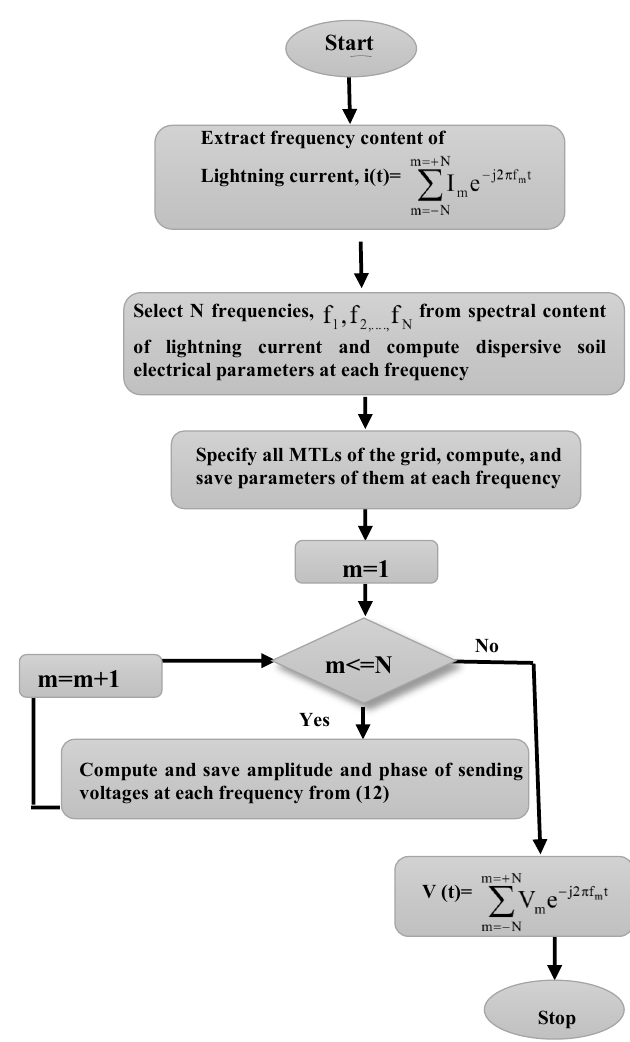
Figure 3: Flow chart of the MTL in dispersive soils.